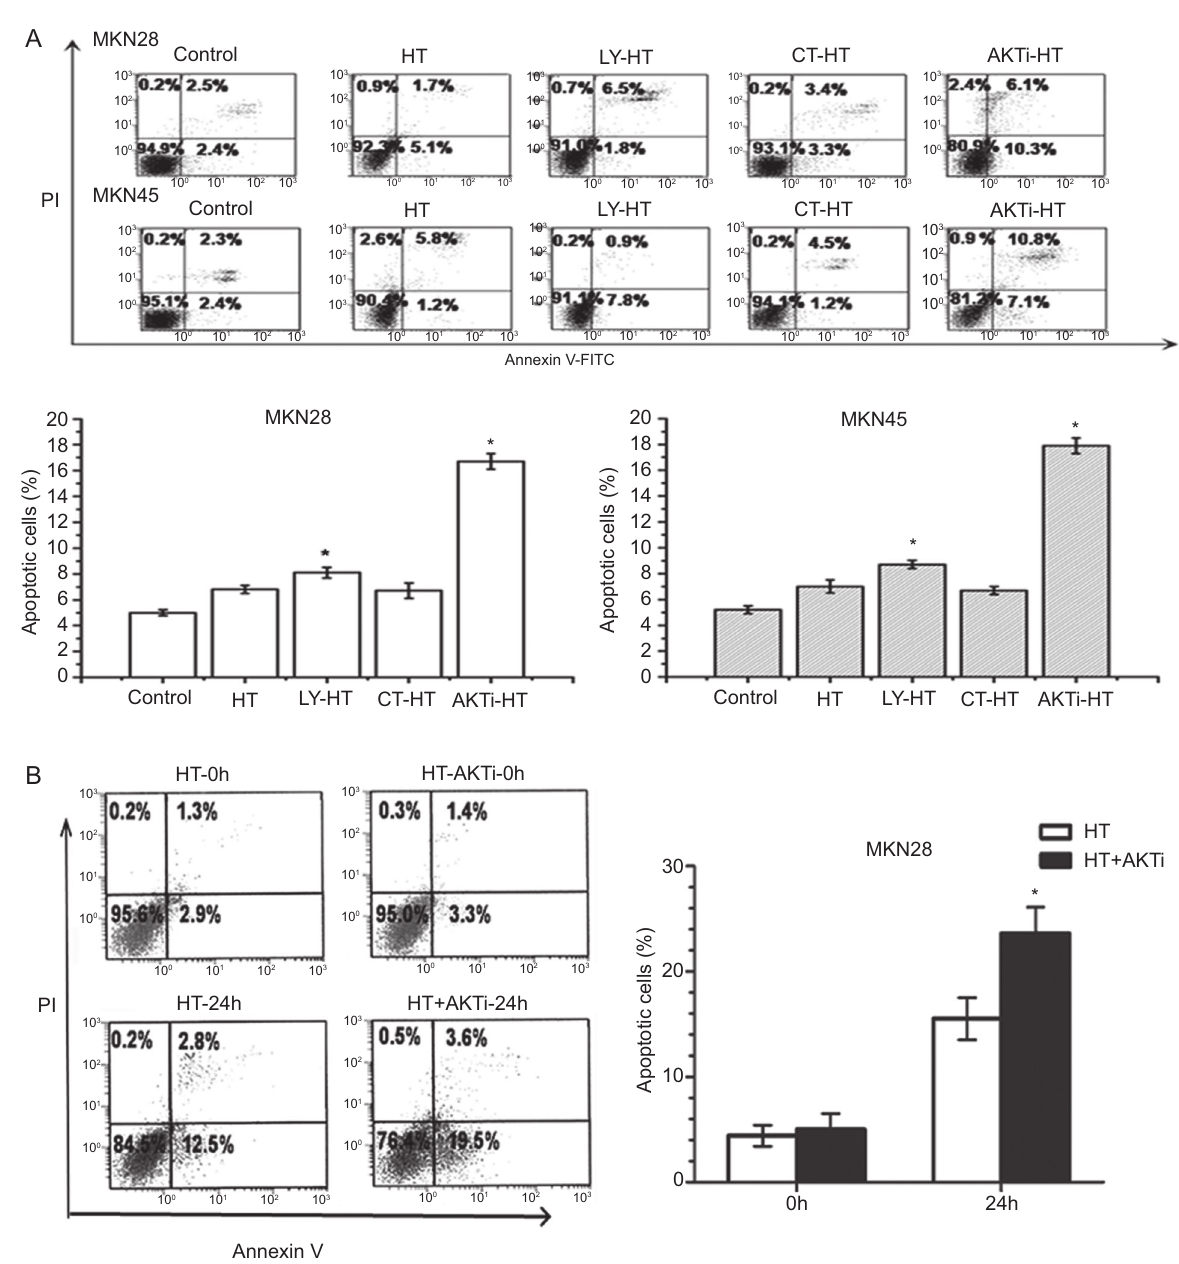
Figure 5. AKT inhibitor promoted hyperthermia-induced apoptosis in gastric cancer cells. A , MKN28 and MKN45 cells were assigned to 5 groups according to the treatment mentioned in Figure 4: HT group; CT-HT group; LY-HT group; AKTi-HT group, and control group. The apoptotic cells were stained with Annexin V/propidium iodide (PI) 12 h after the treatment, and apoptosis rate was determined by flow cytometry. The results are shown as histograms. Data are reported as means ± SD of at least 3 independent experiments. B , MKN28 cells were assigned to 4 groups according to treatment. The apoptotic cells were stained with Annexin V/PI at 0 and 24 h after treatment, and apoptosis rates were detected by flow cytometry. *P , 0.05 compared to the HT group (Student t